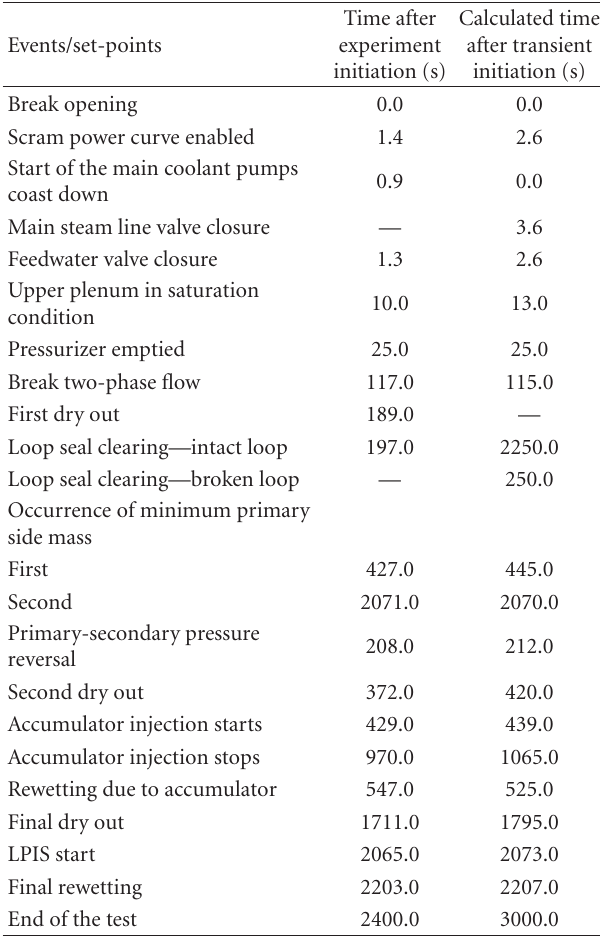
Table 3: Resulting sequence of events, comparison between experi- mental test and calculated results of